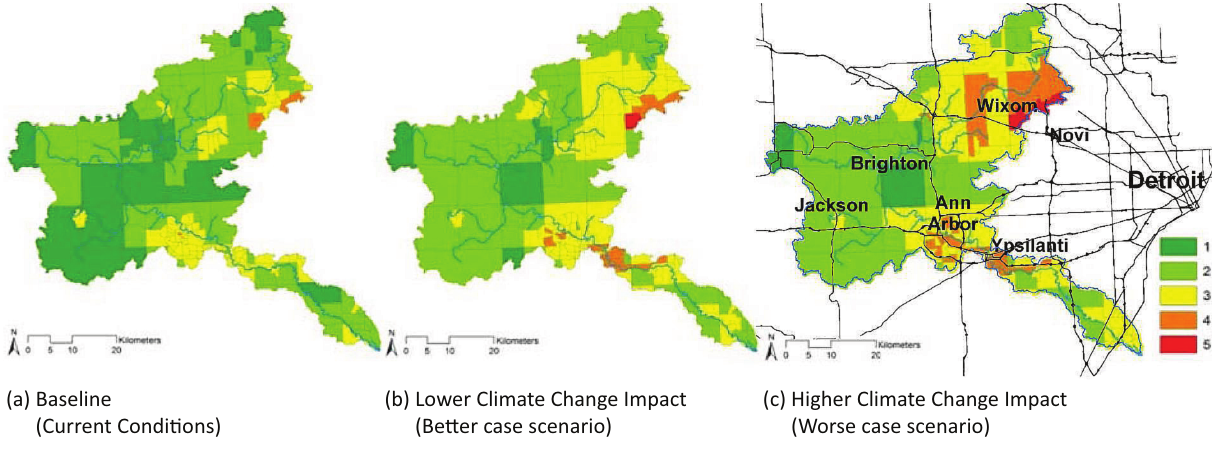
Figure 2. The Climate Justice maps as included in the survey illustrate the results from a previous study conducted for the Huron River watershed in Michigan, which found various degrees of climate change impacts of flooding and associated en- vironmental hazards (Cheng, 2016; Xu et al., 2007). The following texts were used in the survey to describe the maps: “The color represents a 5-scale ranking and the orange (scale = 4) and red (scale = 5) colors indicate places where 1) flooding is more likely to occur as the climate changes, 2) more environmental hazards occur (contaminated sites, waste disposal facilities etc.), and 3) a higher portion of the population is vulnerable to disasters (elderly, children, minorities,